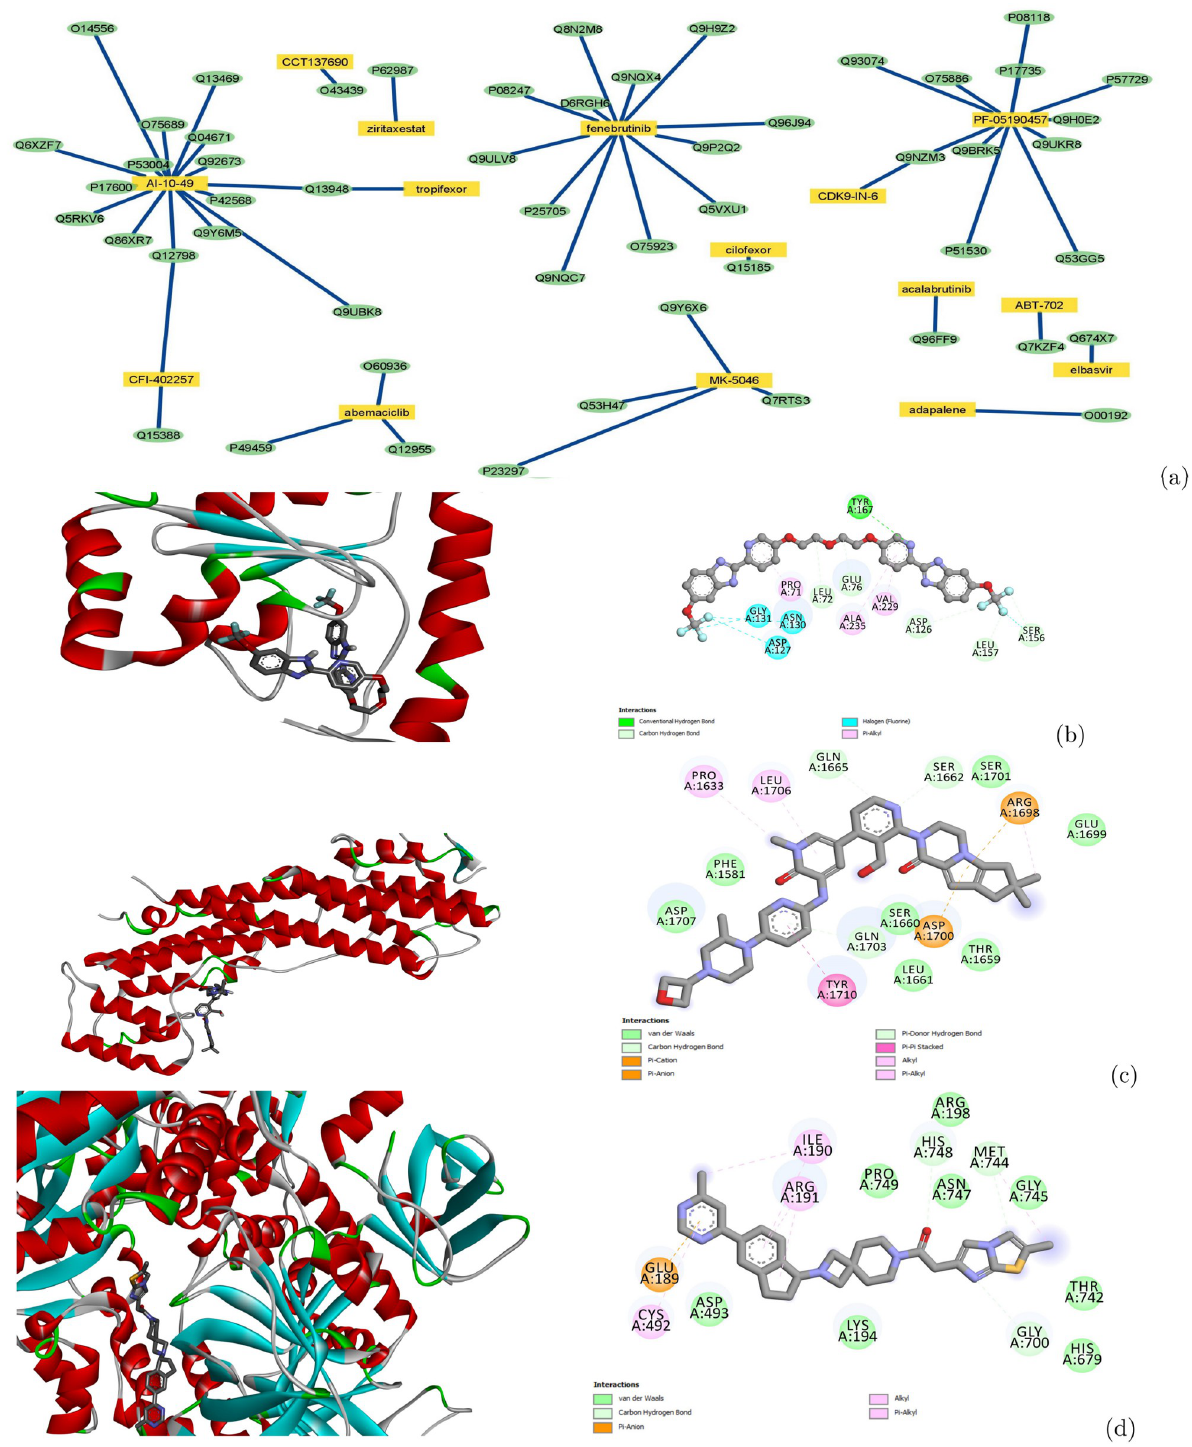
Fig 5. Drug-target interaction network for proteins associated with Alzheimer’s disease and docking poses for representative drug-target pairs calculated by Autodock Vina. (a) Drug-target interaction network predicted by PortalCG. Yellow rectangles and green ovals represent drugs and targets, respectively. (b) Docking pose and ligand binding interactions between protein TIR domain-containing adapter molecule 2 (Uniprot: Q86XR7) and AI-10–49. (c) Docking pose and ligand binding interactions between protein Unconventional myosin-Vc (Uniprot: Q9NQX4) and fenebrutinib. (d) Docking pose and ligand binding interactions between DNA replication ATP-dependent helicase/nuclease (Uniprot: P51530) and PF-05190457. https://doi.org/10.1371/journal.pcbi.1010851.g005 PLOS Computational Biology | https://doi.org/10.1371/journal.pcbi.1010851 January18, 2023 16 /